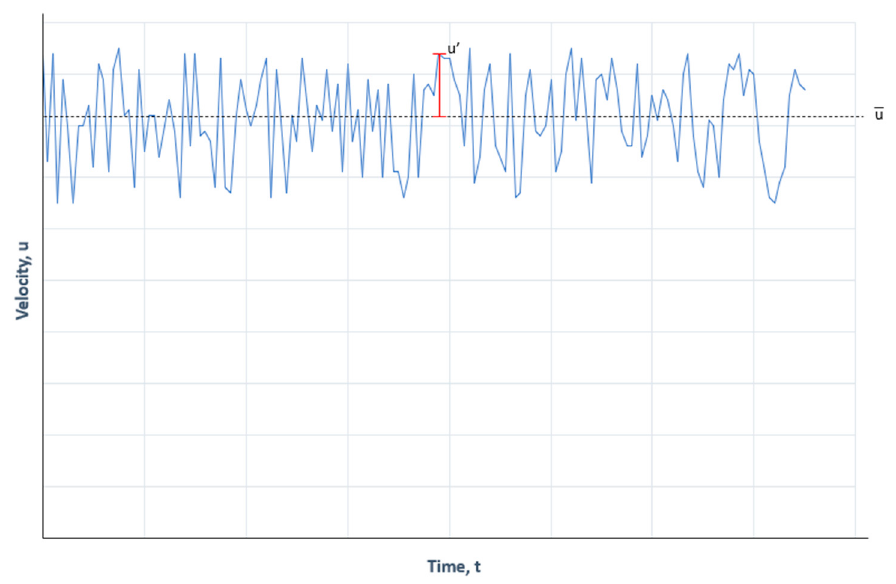
Figure 8. Depiction of turbulent velocity fluctuation.